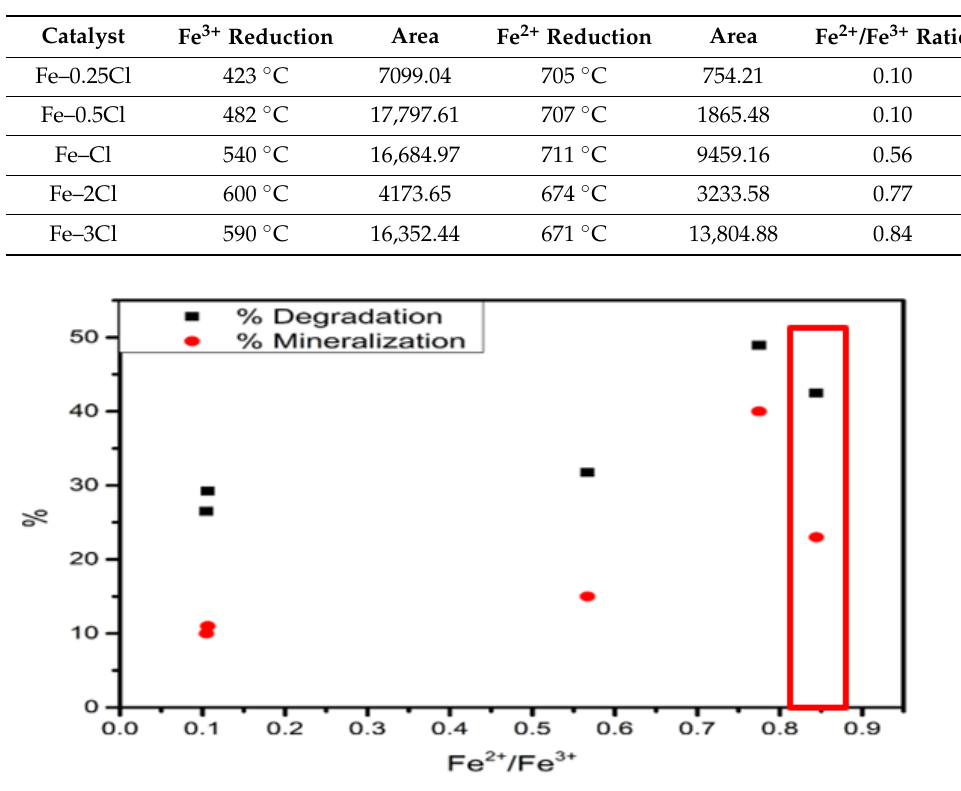
Figure 16. Fe 2+ /Fe 3+ ratio vs. degradation and mineralization.